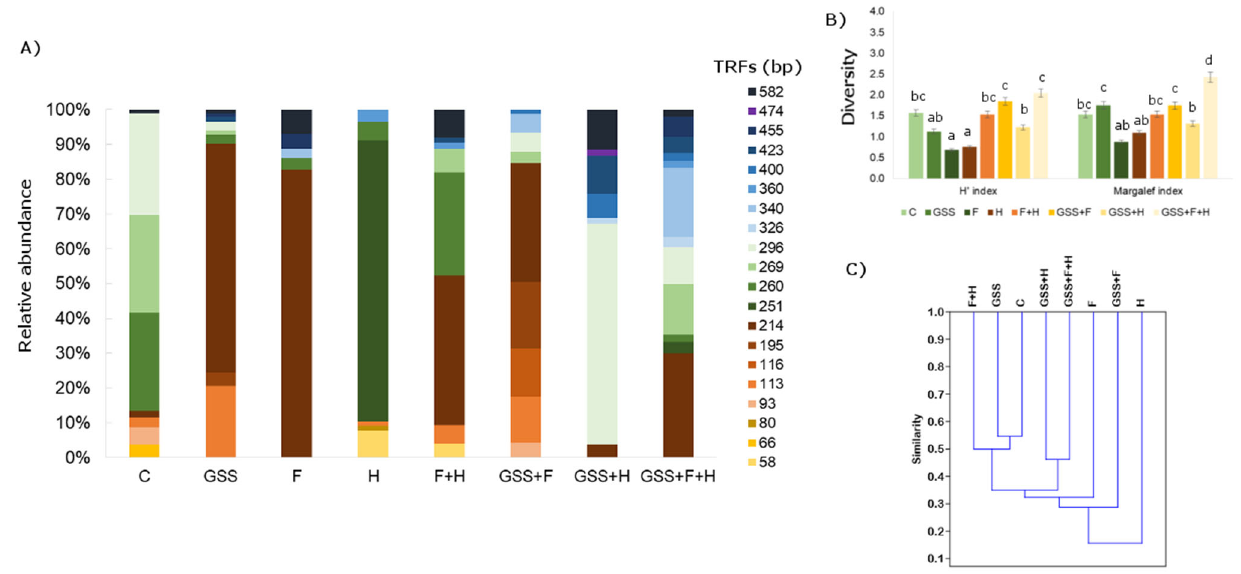
Figure 2. ( A ) Relative abundance (%) of bacteria TRFs fragments after MspI digestion; ( B ) Shannon (H ′ ) and Margalef diversity indexes and ( C ) dendrogram presenting Jaccard similarity index ( C ). The data presented in ( B ) are means ± SD; the same letters mean non ‐ significant differences between treatments assessed by Tukey post hoc HSD test at p < 0.05.